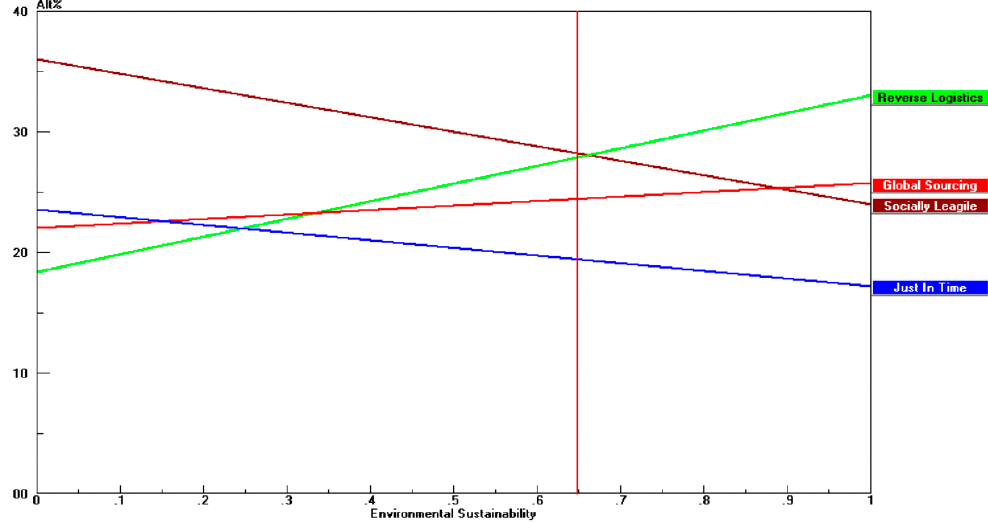
Figure 10. Sensitivity analysis of alternatives w.r.t. Environmental sustainability weight.